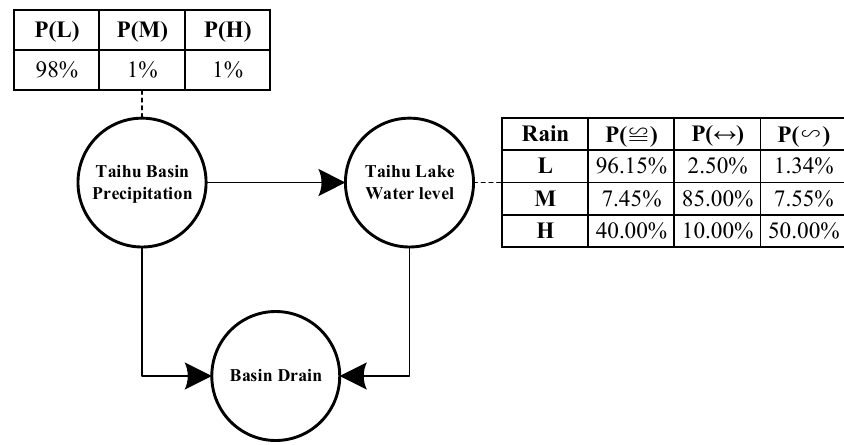
Figure 8. Bayesian network structure parameter map of the plum rain period.